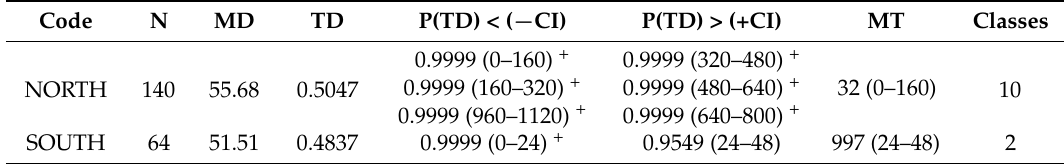
Table 3. Analysis of spatial genetic structure among P. engelmannii seed stands by considering a distance class width of 160 m in the northern stands and 24 km in the southern stands, 999 permutations, and a 99% confidence interval. The mean Tanimoto distance (TD) was calculated using Spatial Genetic Software 1.0